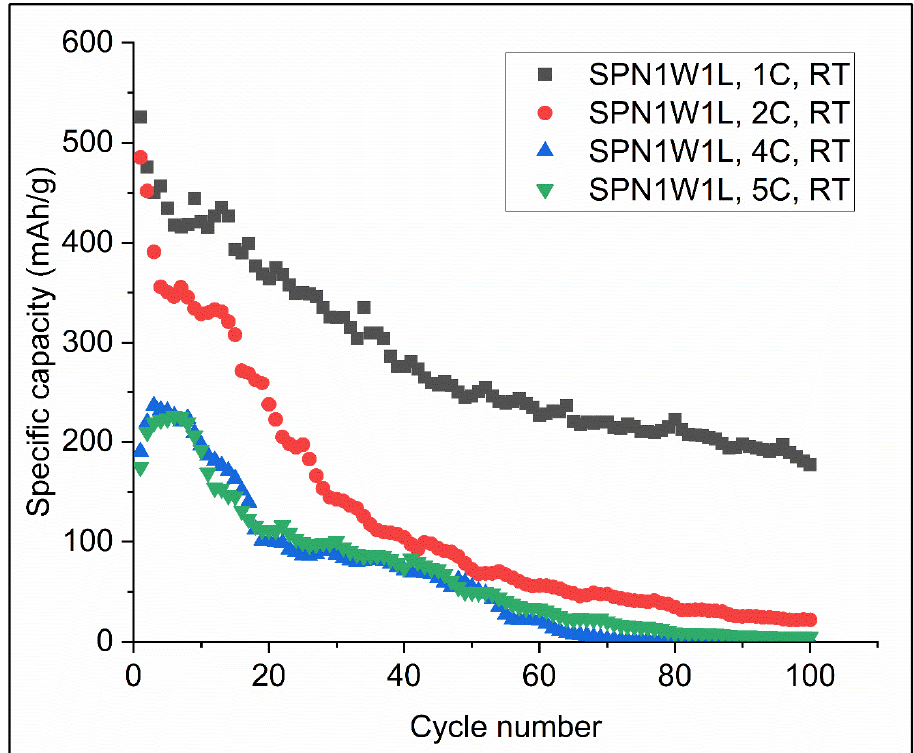
Figure 6. Cyclic performance of the SPNWL, Ni/W = 1:1 batteries at 1C, 2C, 4C, and 5C.